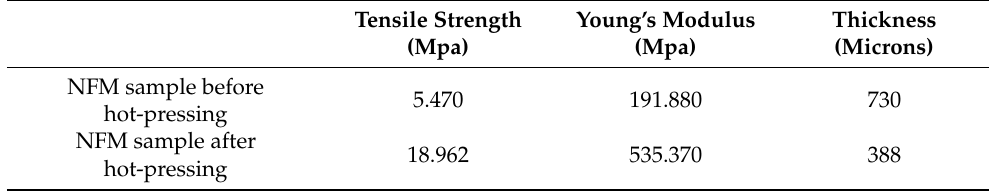
Table 2. Mechanical properties of PES-based NFM supports before and after hot-pressing post-treatment.